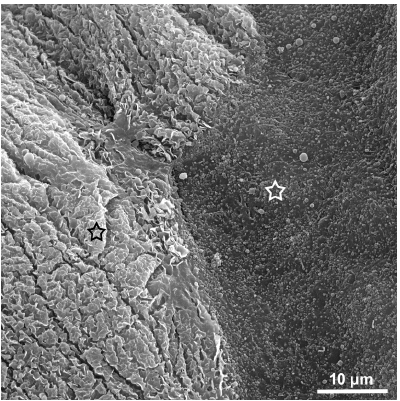
Figure 3. Apical plasma membrane of normal and cancer urothelial cells. Distinctive difference between scalloped apical membrane of normal umbrella cells on the left (black rimmed asterisk) and microvillar apical membrane of cancer cells on the right side (white rimmed asterisk) of the micrograph taken by scanning electron microscope.